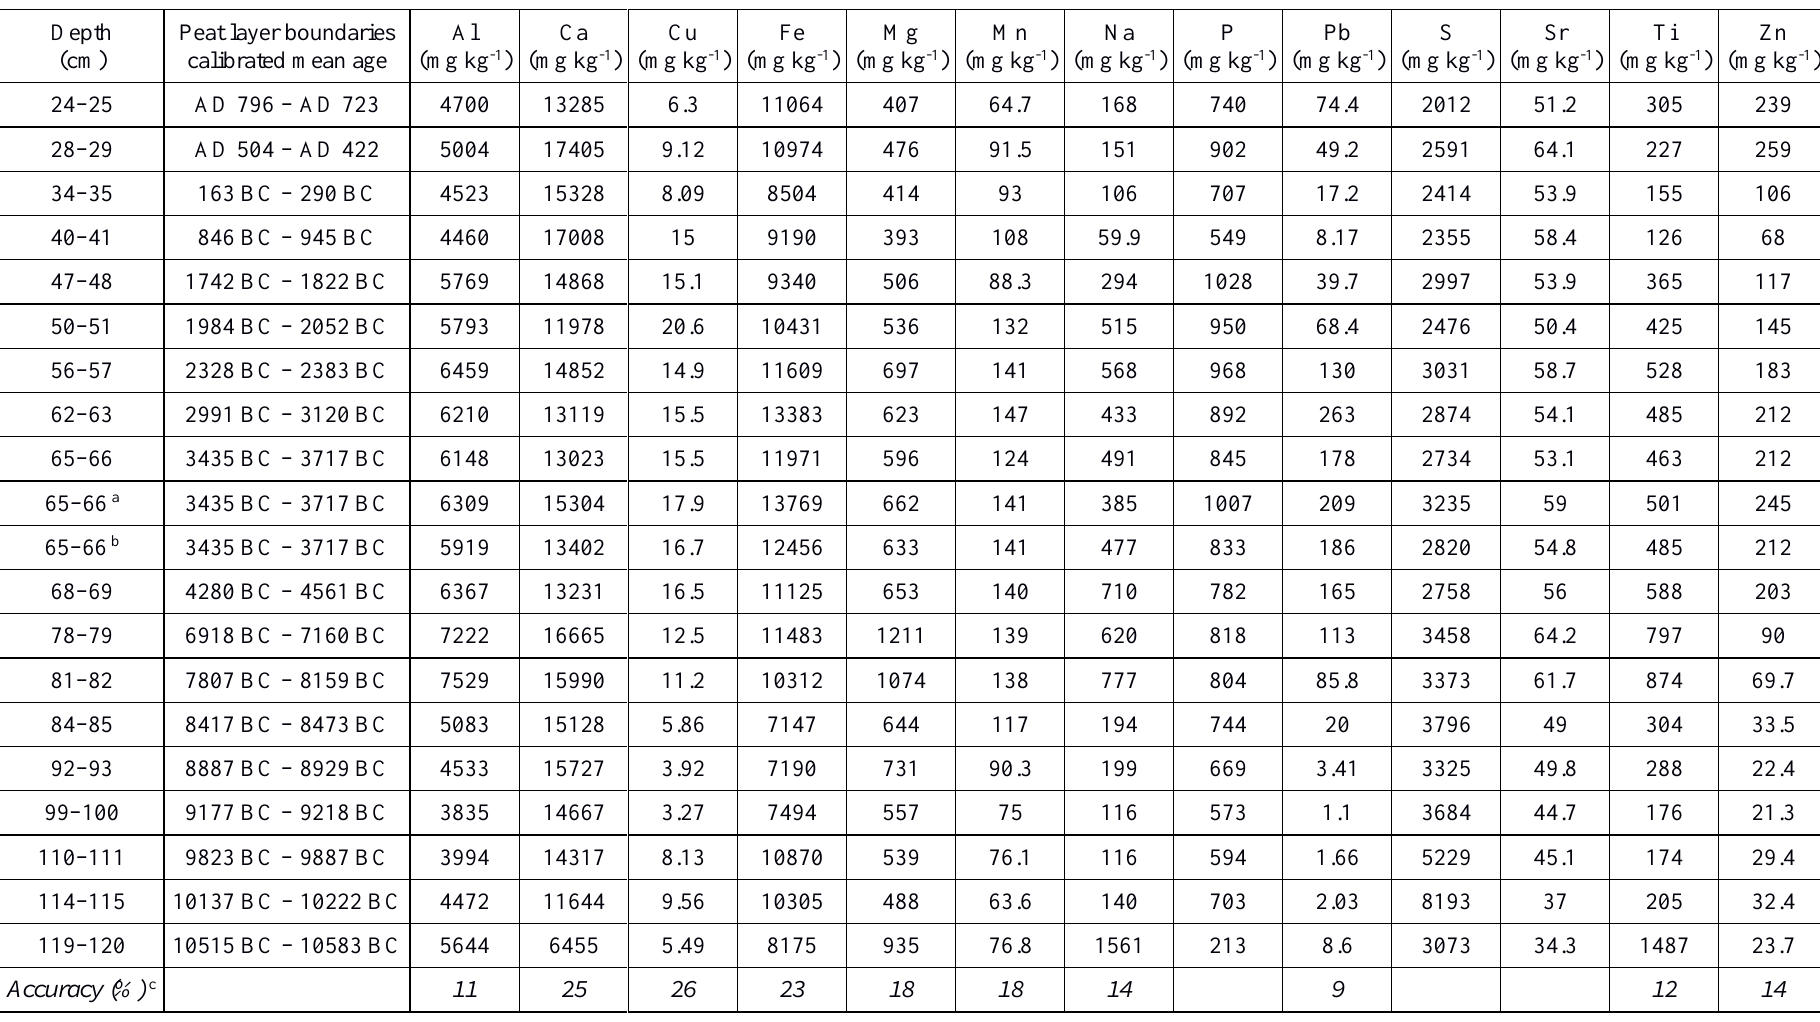
Table 1. Elemental geochemistry measurements on selected peat samples from Żyglin 3 core. Notes: a the entire procedure was replicated for the 65–66 cm sample; b second analysis of the 65–66 cm sample; c accuracy is assigned for concentrations of elements in the corresponding columns except for P, S and Sr, which were not certified in the reference materials